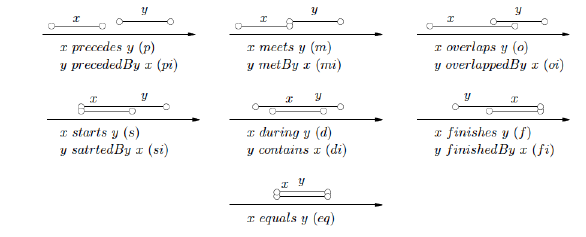
Figure 9. Allen’s intervals algebra atomic relations